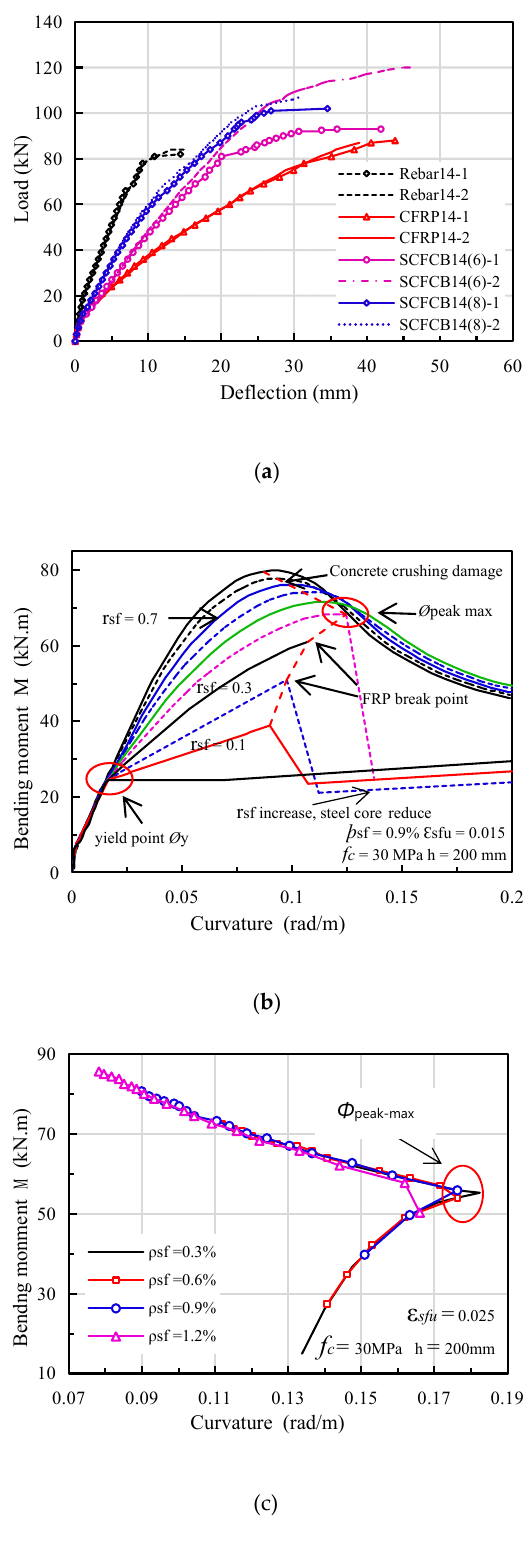
Figure 4. Relationship between load and mid-span deflection. ( a ) load–span mid-deflection curve. ( b ) moment–curvature of SCFCB beam [30]. ( c ) maximum possible curvature [30].